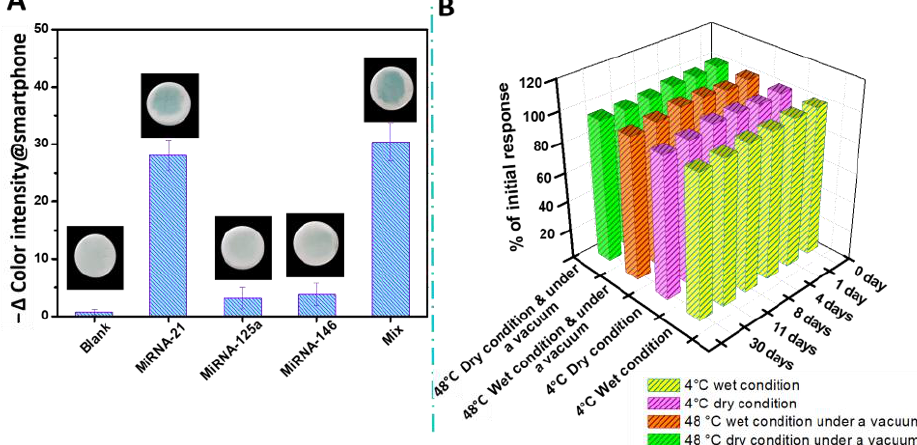
Figure 5. ( A ) Selectivity study toward noncomplementary miRNAs (miR-125a, miR-146,) and a mixture of three microRNAs. ( B ) Stability study of the paper-based genosensor during various storage times (1 day, 4 days, 8 days, 11 days, and 30 days) in various storage conditions using 100 pM of the target. Three parallel experiments yielded error bars.